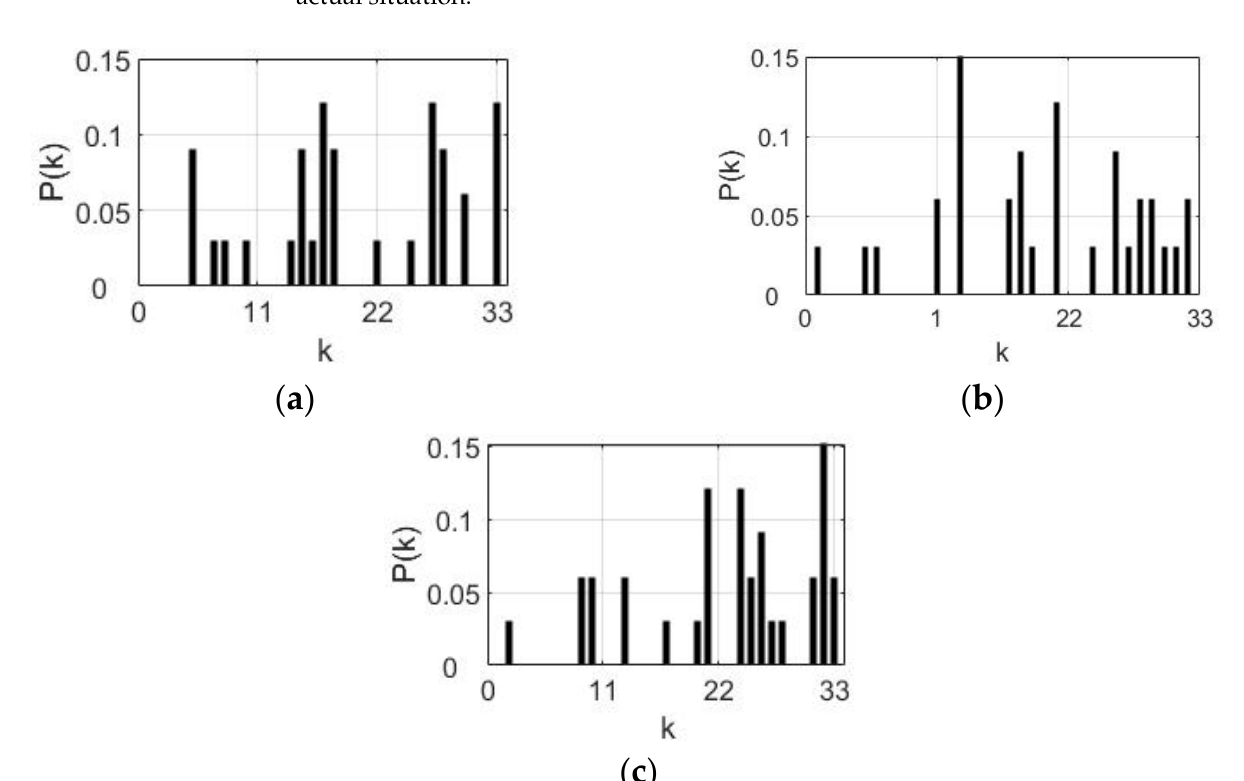
Figure 8. The degree distribution in the three kinds of movements: ( a ) appropriate angle, ( b ) excessive angle, ( c ) angle too small.